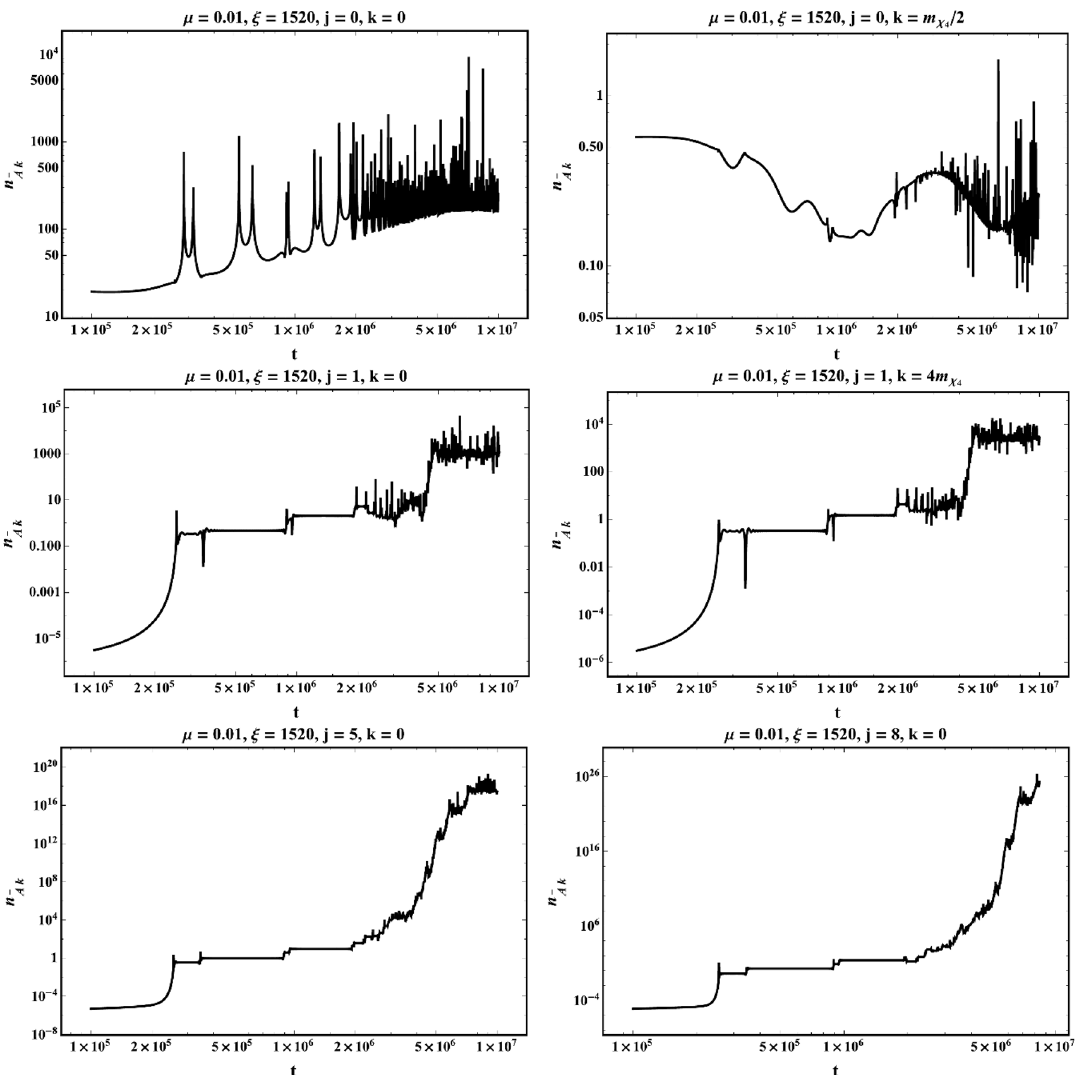
Figure 12 . The time evolution of number density of the gauge preheat (cid:12)elds (cid:22) A i for (cid:22) = 0 : 01 and (cid:24) =